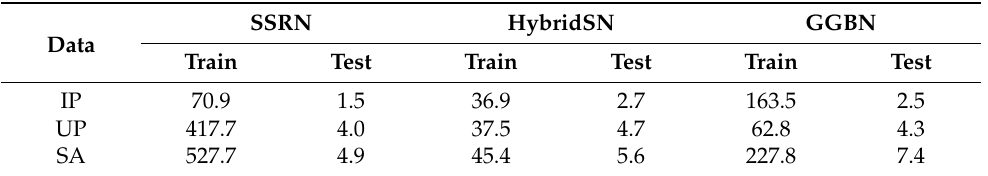
Table 1. The training and testing time in seconds over IP, UP, and SA datasets using SSRN, HybridSN, and GGBN model.